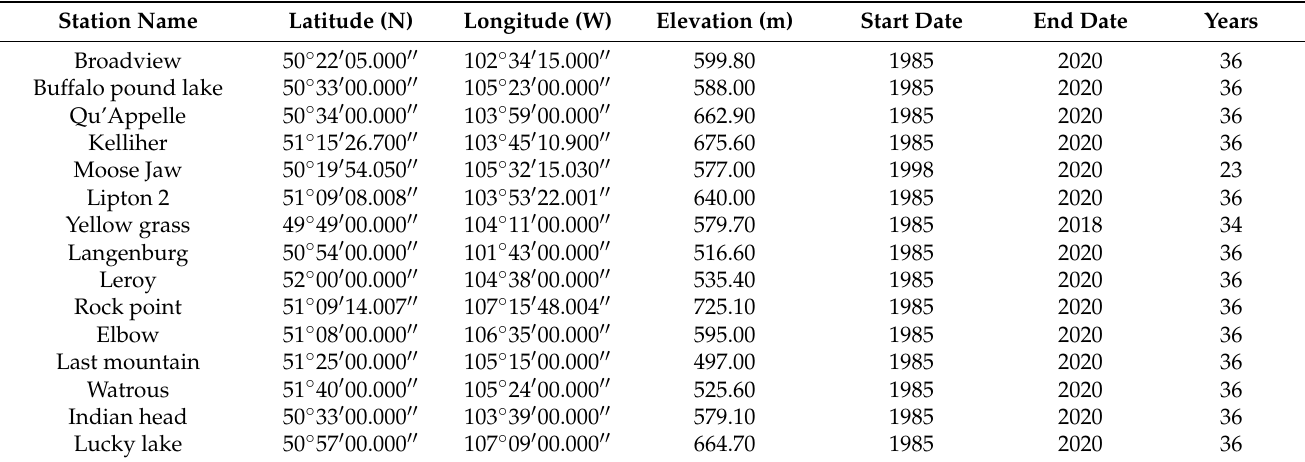
Figure 1. Map of the study region (modified after [24]). Table 1. Summary of climate station.